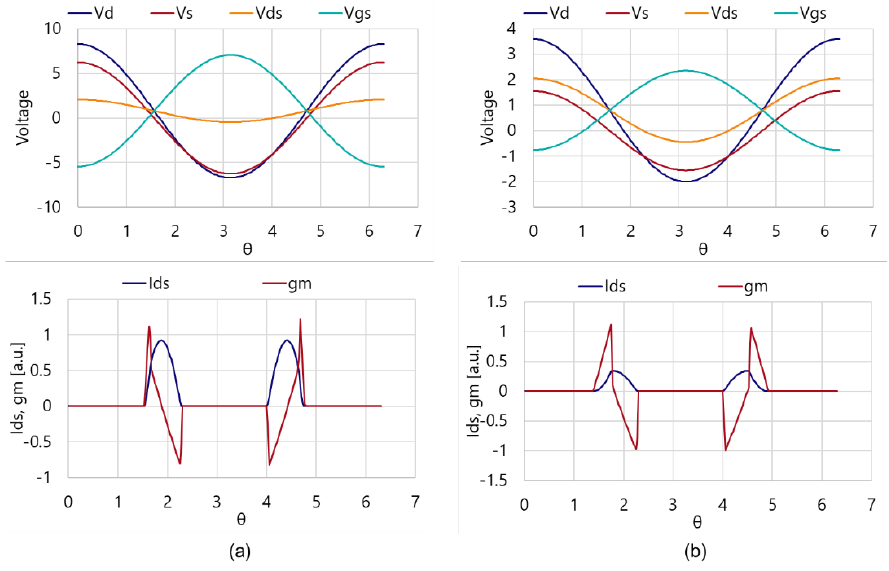
Figure 12. Waveform in cases of A CG = 1.2 ( a ) and 1.8 ( b ) .